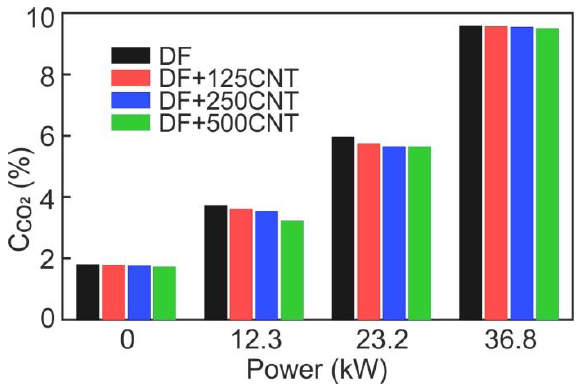
Figure 9. Change in carbon dioxide ( C CO at different diesel engine loads.